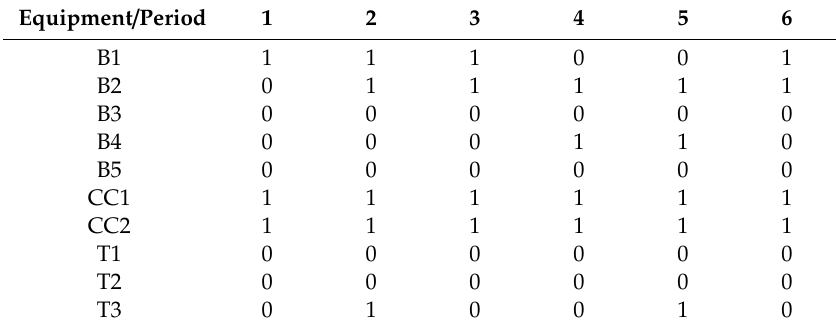
Table 13. Optimal scheduling results of start / stop of multi-period operation equipment.